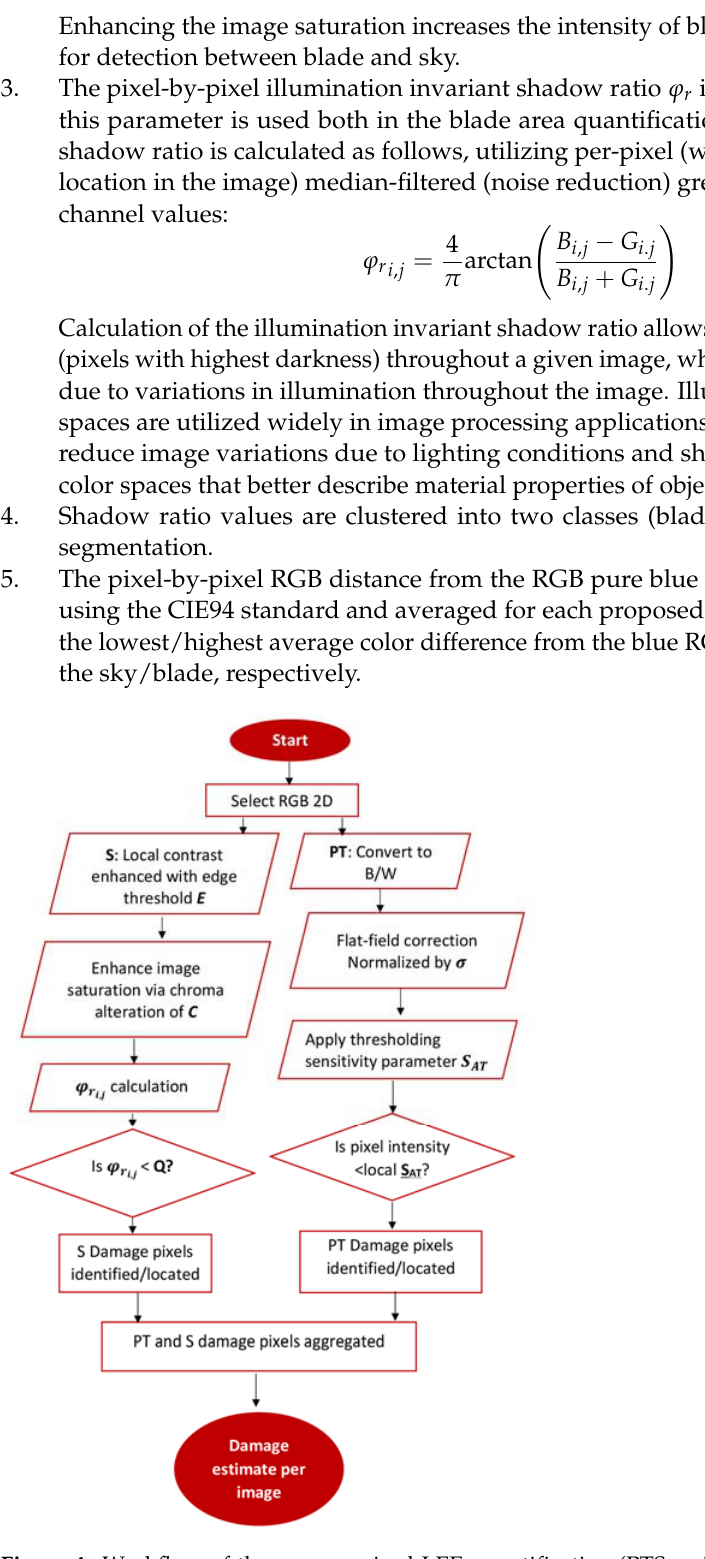
Figure 4. Workflow of the unsupervised LEE quantification (PTS—pixel intensity threshold and Figure 4. Work fl ow of the unsupervised LEE quanti fi cation (PTS—pixel intensity threshold and shadow ratio) module shadow ratio) module 2.